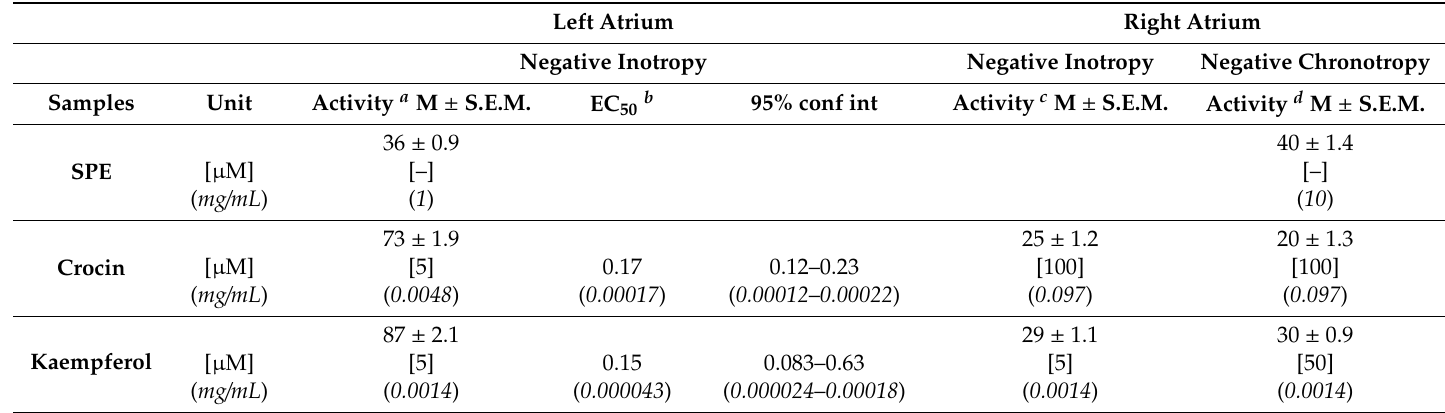
Table 2. Cardiac activity of SPE, crocin, and